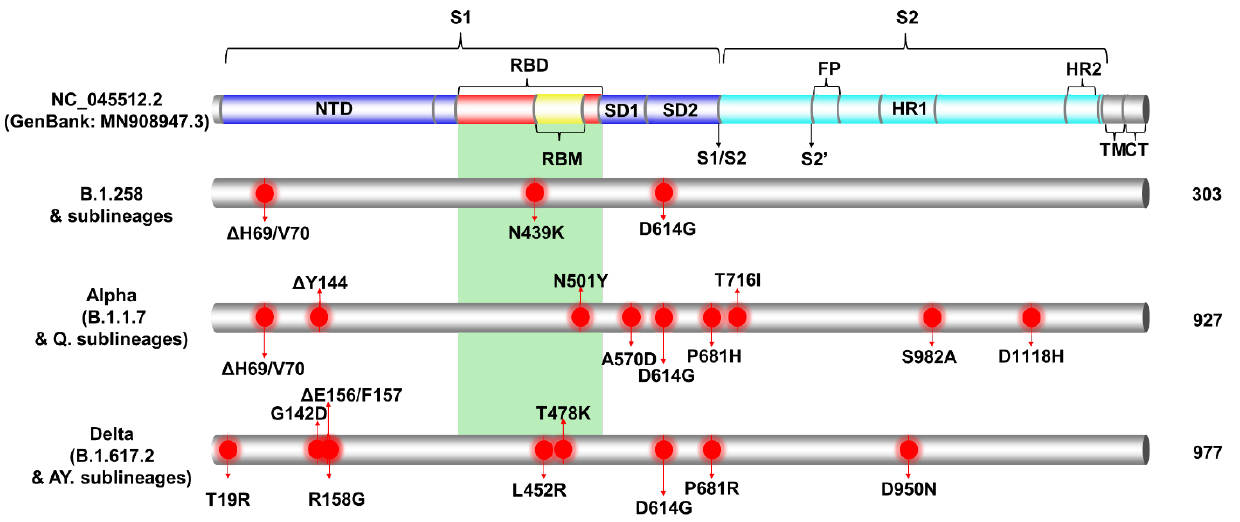
Figure 3. The most common S protein mutations of the most prevalent lineages identified from Cypriot SAR-CoV-2 sequences, samples of which were collected from November 2020 to October 2021. Specifically, this figure presents the most common S protein mutations of the most prevalent lineages of the second wave (B.1.258 & sublineages), the third wave (Alpha, B.1.1.7 & Q. sublineages), and the fourth wave (Delta, B.1.617.2 & AY. sublineages). The colored cylinder depicts key domains of the SARS-CoV-2 S protein (NC_045512.2) (GenBank: MN908947.3). NTD, N-terminal domain; RBD, receptor-binding domain (red); RBM, receptor-binding motif (yellow); SD1, subdomain 1; SD2, subdomain 2; FP, fusion peptide; S1, subunit 1 (blue); S2, subunit 2 (cyan); HR, heptad repeats; TM, transmembrane domain (gray); CT, cytoplasmic tail (gray). Cleavage sites are depicted with black arro ws, S1/S2 and S2′, respectively. The green -highlighted region corresponds to the receptor- binding domain (RBD) [56,58 – 66]. Mutations were identified using the Nextclade webtool ( https://clades.nextstrain.org , date accessed 9 May 2022) [35]. Red circles indicate locations of the most common mutations identified in all or nearly all of the sequences in a lineage. The total number of sequences per lineage in this study is indicated on the right-hand side of the figure.